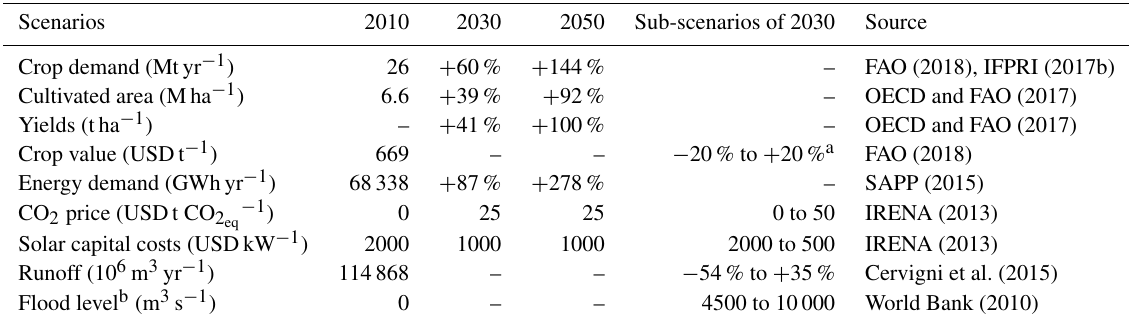
Table 4. Main scenarios. The table presents trends in the water, energy, and agriculture sectors for the three main scenarios: 2010, 2030, and 2050. The sub-scenarios are relative to the 2030 scenario, to evaluate the sensitivity of the results to climate change, world market crop prices, CO 2 pricing policies, capital costs of solar photovoltaic capacity, and environmental flow policy.